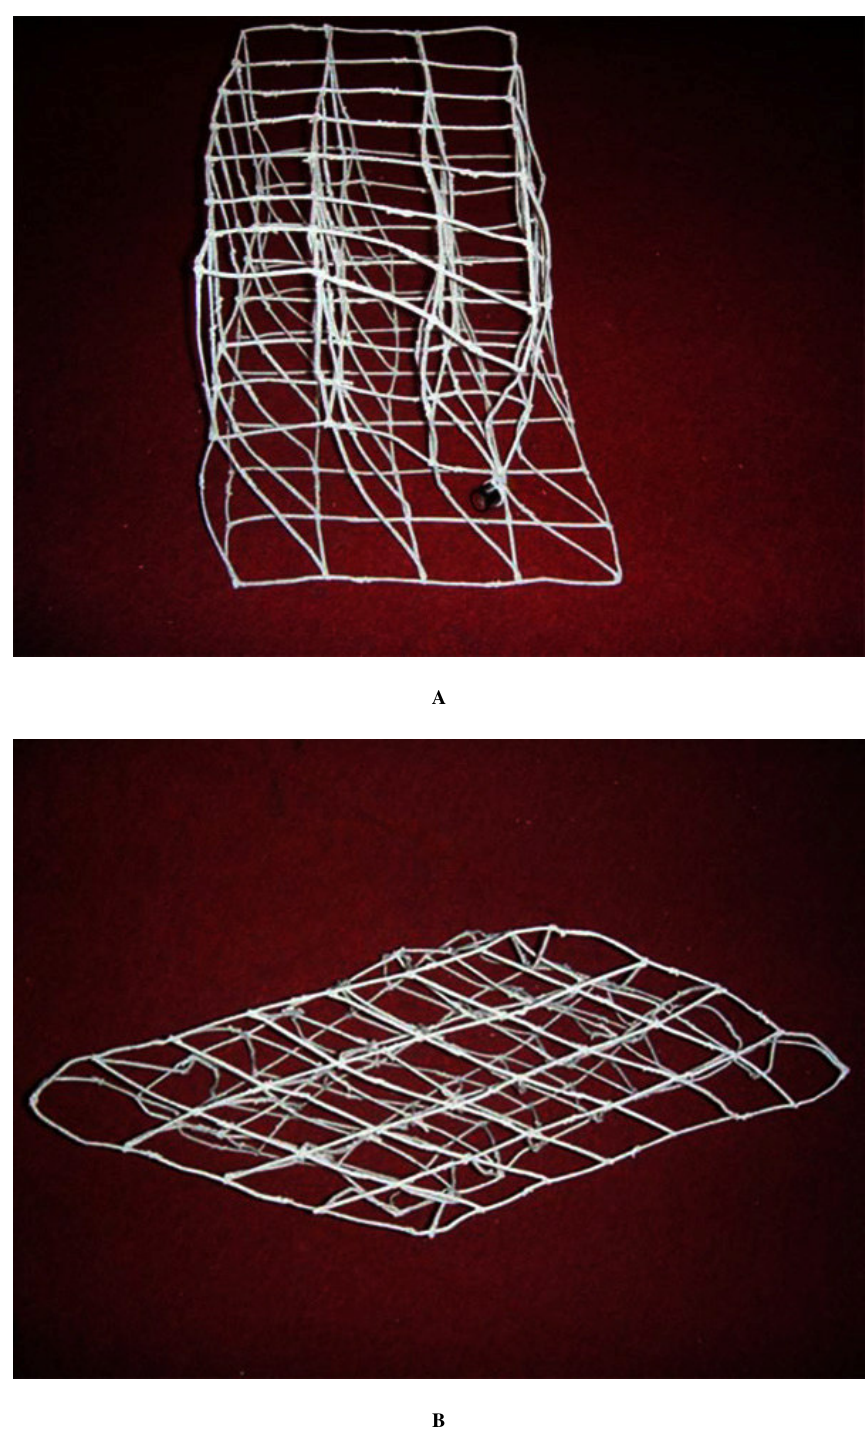
FIGURE 10. A folding of the complex overtone multidimensionality that projects all the tones on the octave axis and, by this, immediately forms an equally floating temperate scale. (A) A folding of a corner of the structure is transmitted throughout the structure. (B) A complete stretch of the system from the two horizontal